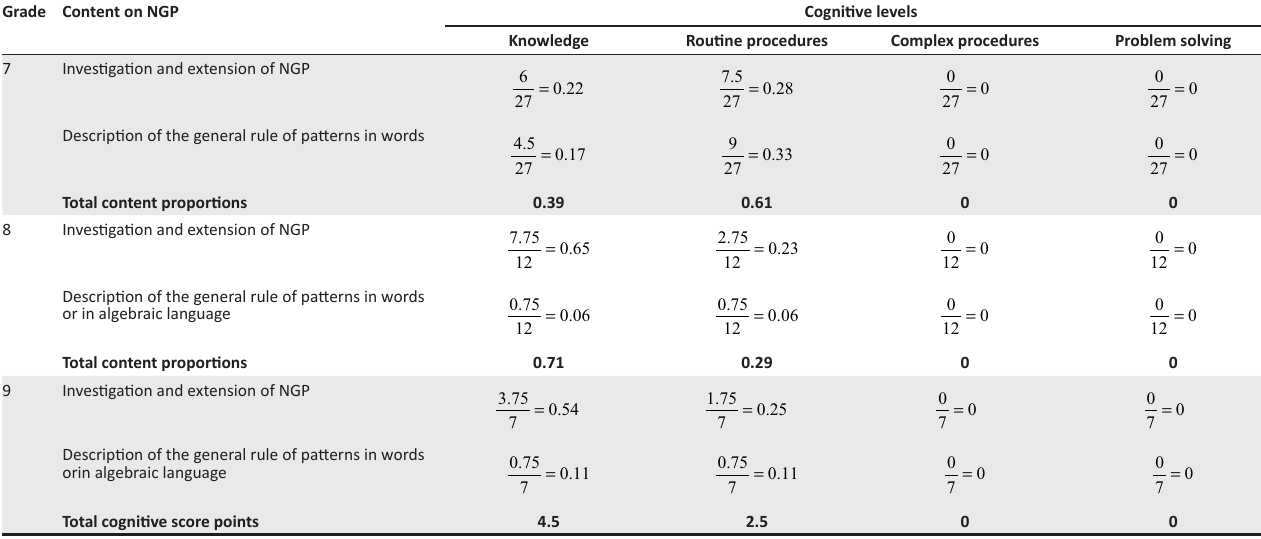
TABLE 5: Grades 7–9 workbook activities on NGP matrix.